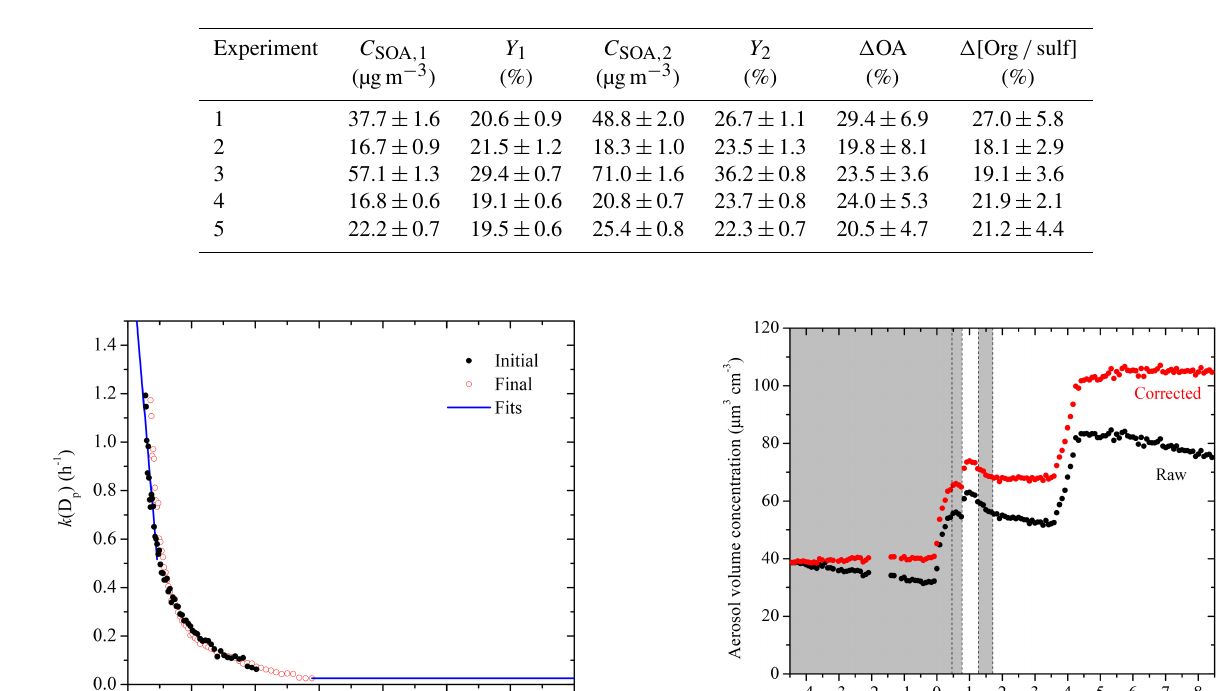
Table 2. SOA mass concentration and yields of the α -pinene ozonolysis aging experiments.